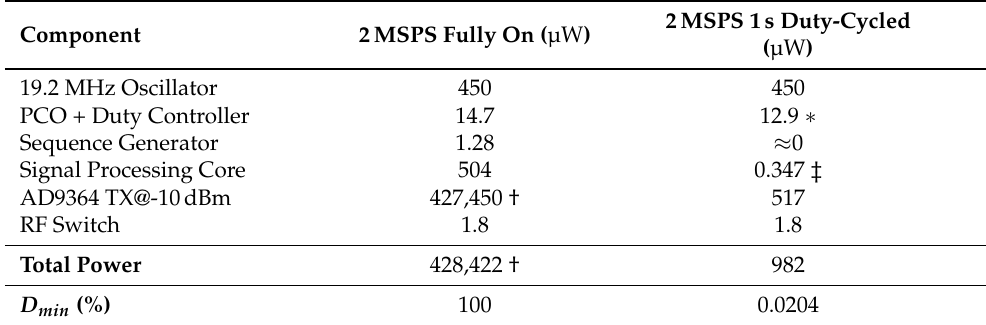
Table 3. Per-component power breakdown for continuous vs. duty-cycled operation at T PCO = 1s corresponding to the measurement in Figure 17. ∗ PCO power decreases slightly with higher count due to decreased switching. † TX and RX fully-on in FDD mode. ‡ Power is dominated by leakage. Component